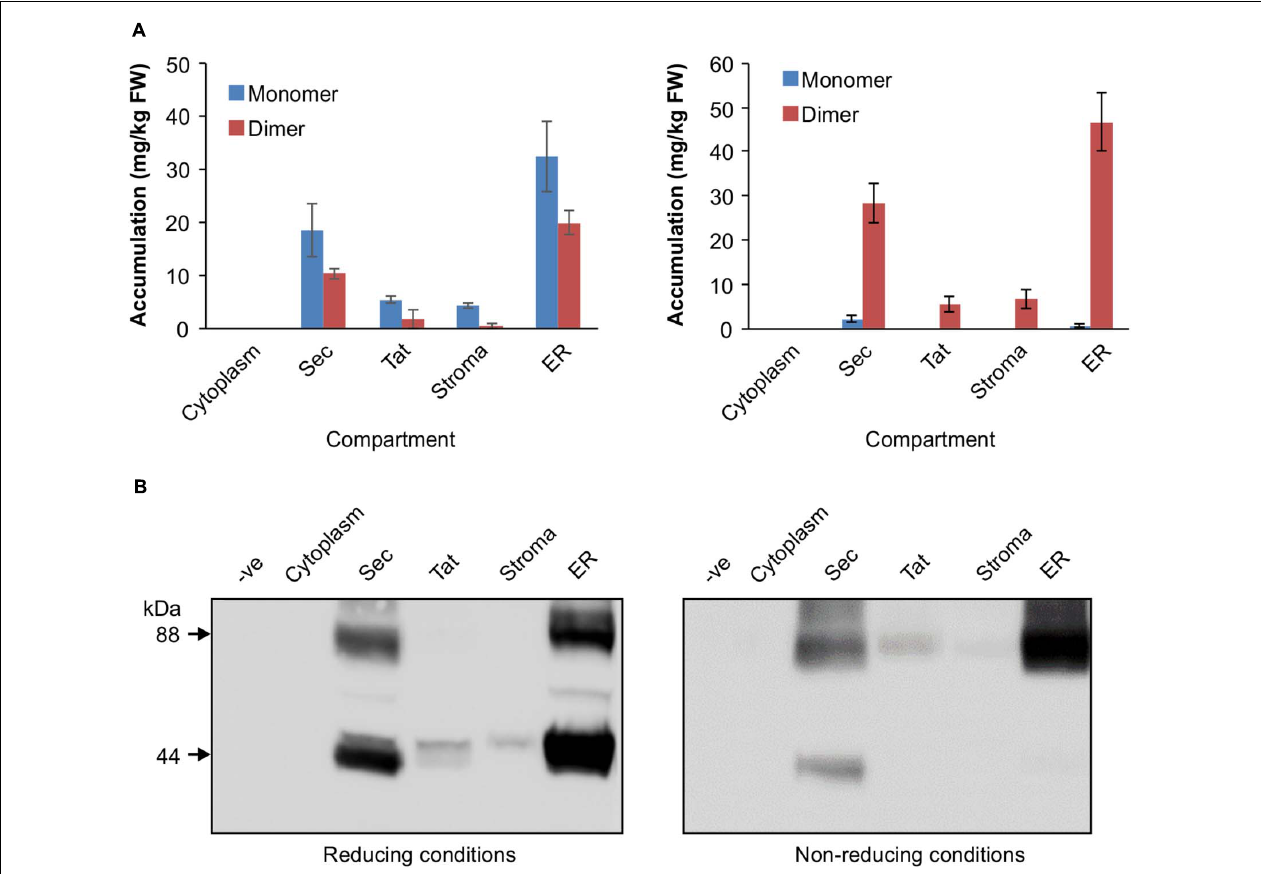
FIGURE 2 | Accumulation profiles of V H H-Fc targeted with cytoplasm, Sec, Tat, stromal, and ER signals. (A) Bar chart comparing V H H-Fc accumulation levels across cytoplasm, Sec, Tat, stromal, and ER signals extracted in reducing (left) or non-reducing (right) conditions. N = 3 biological replicates. Error bars shown are standard error. (B) Representative Western blot showing relative accumulation of V H H-Fc across compartments in reducing (left) and non-reducing (right)